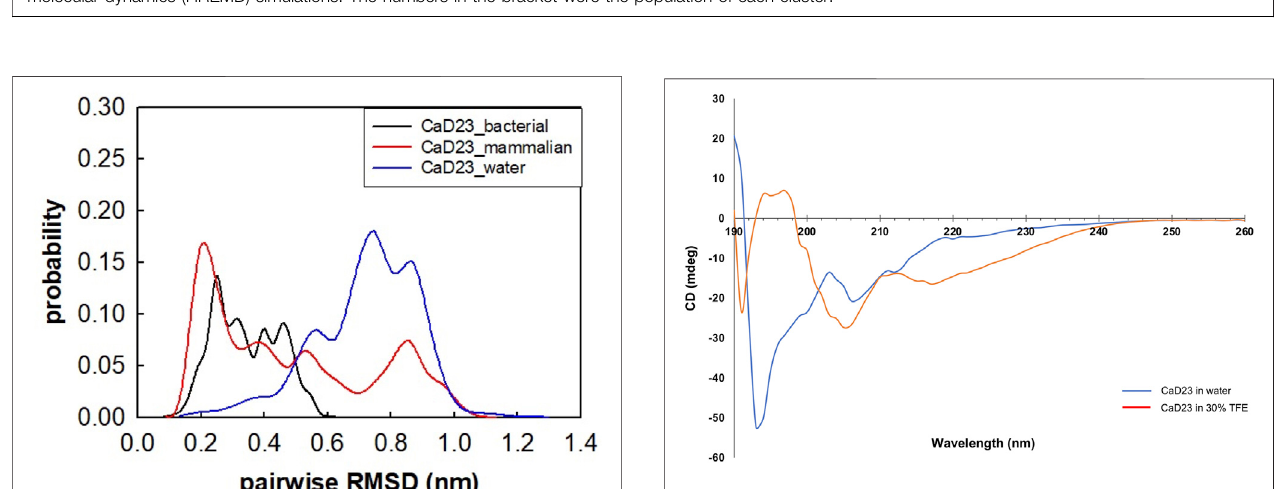
FIGURE 6 | Conformations of the top three clusters of CaD23 in solution, calculated from the last 50 ns of the total 100 ns of Hamiltonian replica exchange molecular dynamics (HREMD) simulations. The numbers in the bracket were the population of each cluster.